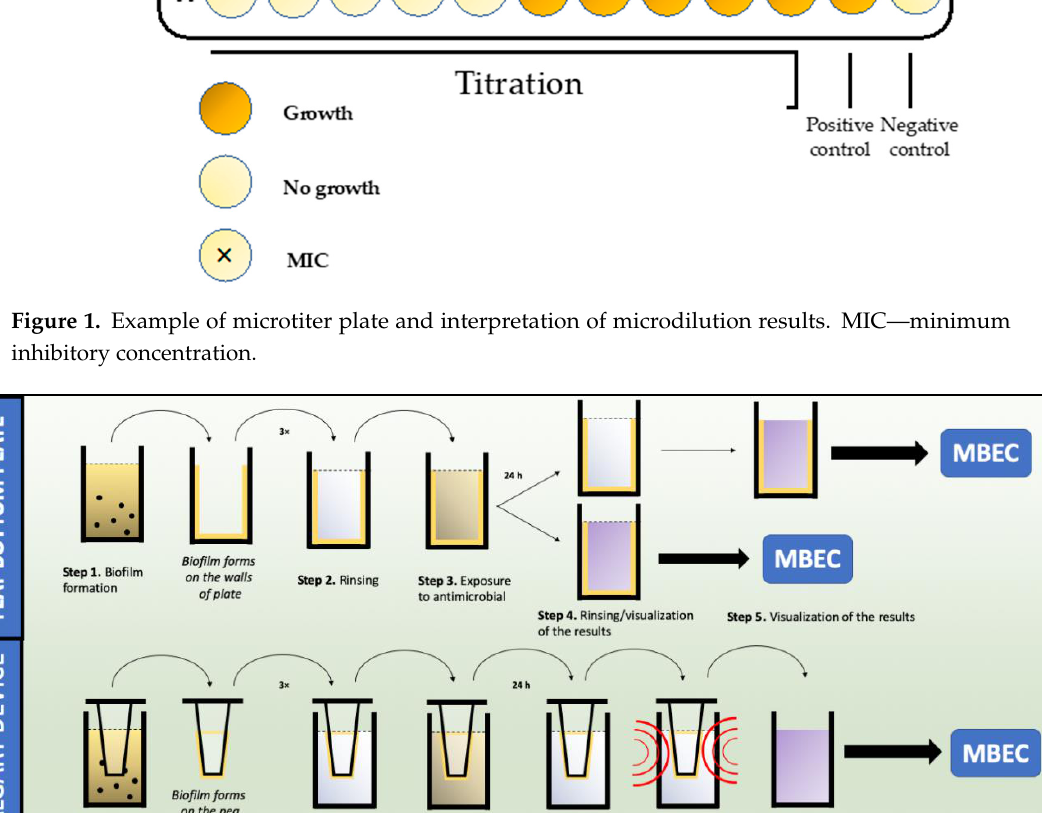
Figure 2. Schematic diagram of MBEC determination.